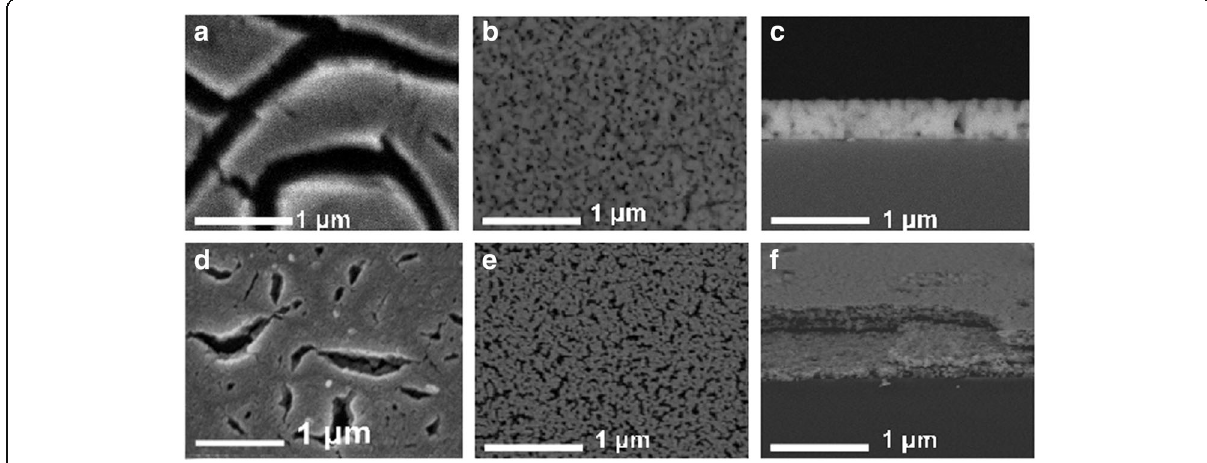
Fig. 5 SEM-images of BST ( a – c ) and LLT ( d – f ) thin film surface ( a , b , d , e ) and cross sections ( c , f ), where thin films a ( c ) and d ( f ) have been obtained via slow drying and with thermal shock usage ( b , c , e , f